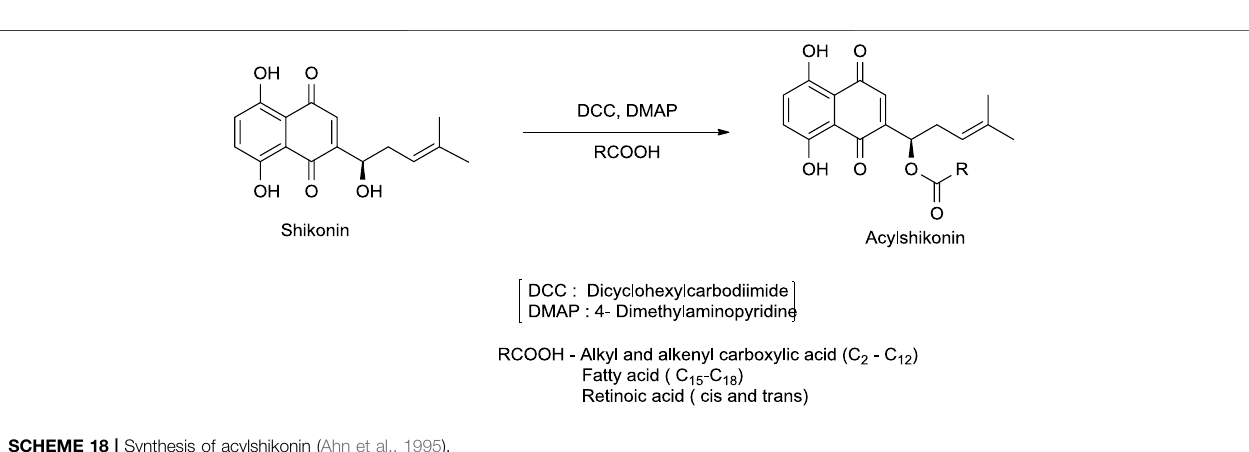
FIGURE 5 | Shikonin derivatives and their occurrence (Papageorgiou et al., 2006).